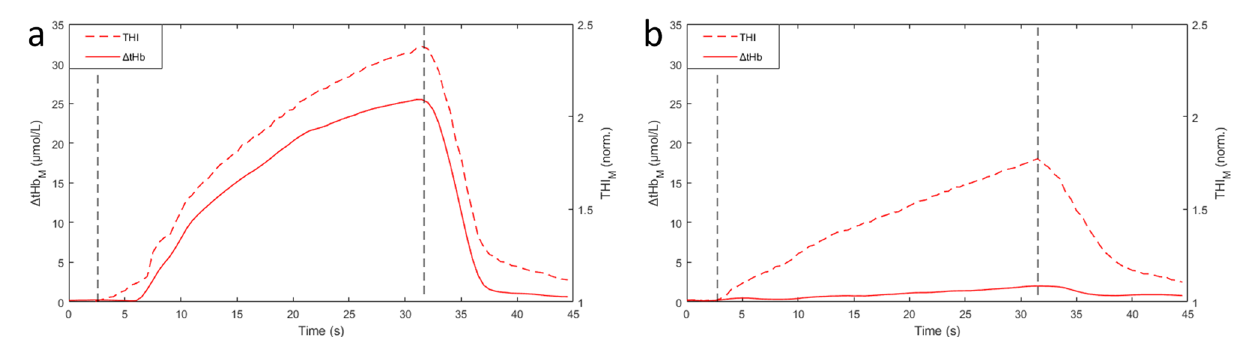
Figure 7. Original traces from the same subject showing tHb and THI responses to 40-mmHg venous occlusions subsequently recorded on the biceps brachii muscle belly at the original site ( a ) and after lateral displacement of 1 cm ( b ). Note the different response of THI, attributed to a small vein in the sample volume in ( b ). Vertical dashed lines indicate start of cuff inflation and to the other probe. Simultaneous US monitoring of the vein confirmed the complete vein collapse during the contraction.